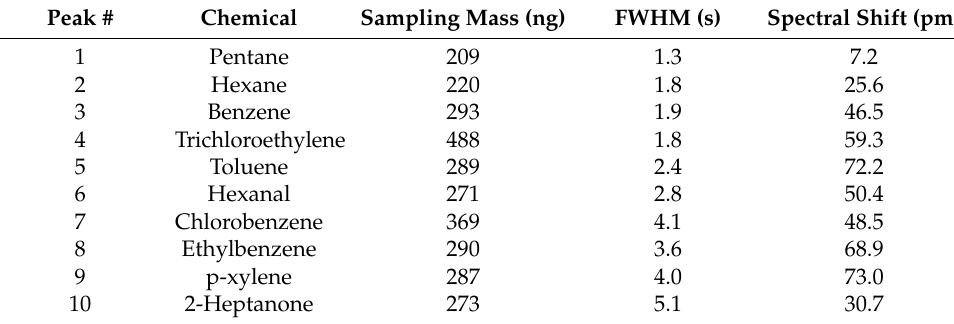
Table 3. Separation performance of the VOC mixtures in Figure 5.